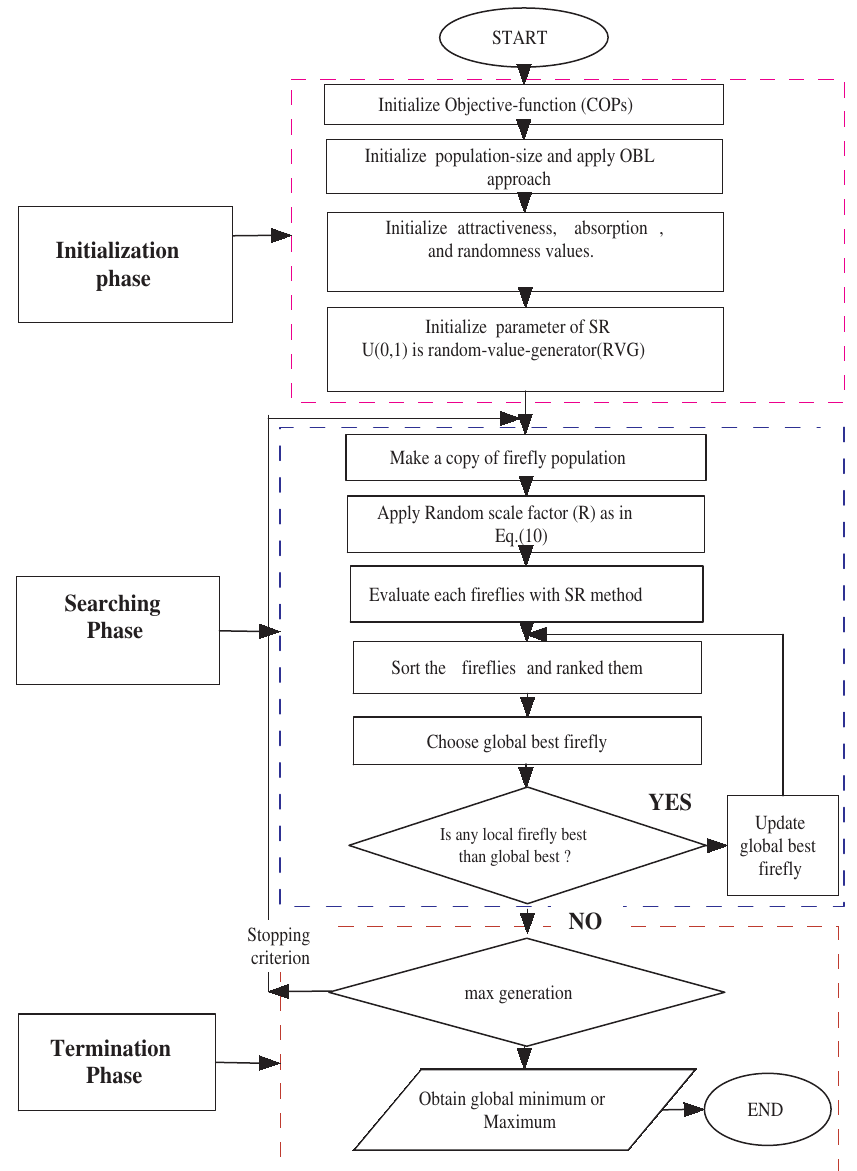
Figure 3. The flowchart of the SRIFA